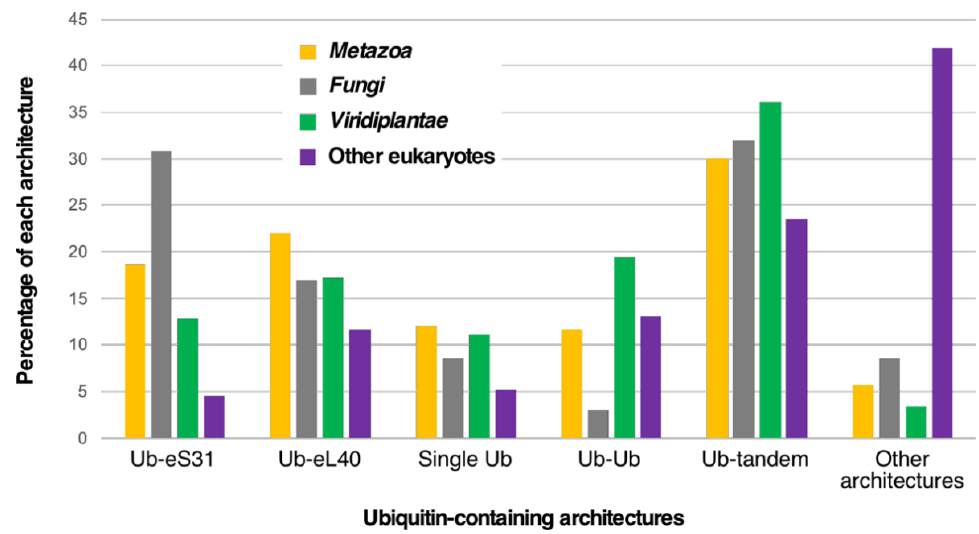
Figure 3. Taxonomic distribution of the most frequent ubiquitin-containing architectures among eukaryotes. Out of all possible architectures, only Ub-eS31 and Ub-eL40 fusions, monogenic Ub, dimeric Ub, and multiple Ub tandem repeats are shown. Analysis was done with different groups of eukaryotes from which we have extracted the Metazoa or animals, Viridiplantae or green algae and plants, and fungi. The percentages corresponding to each architecture category is shown for each group.